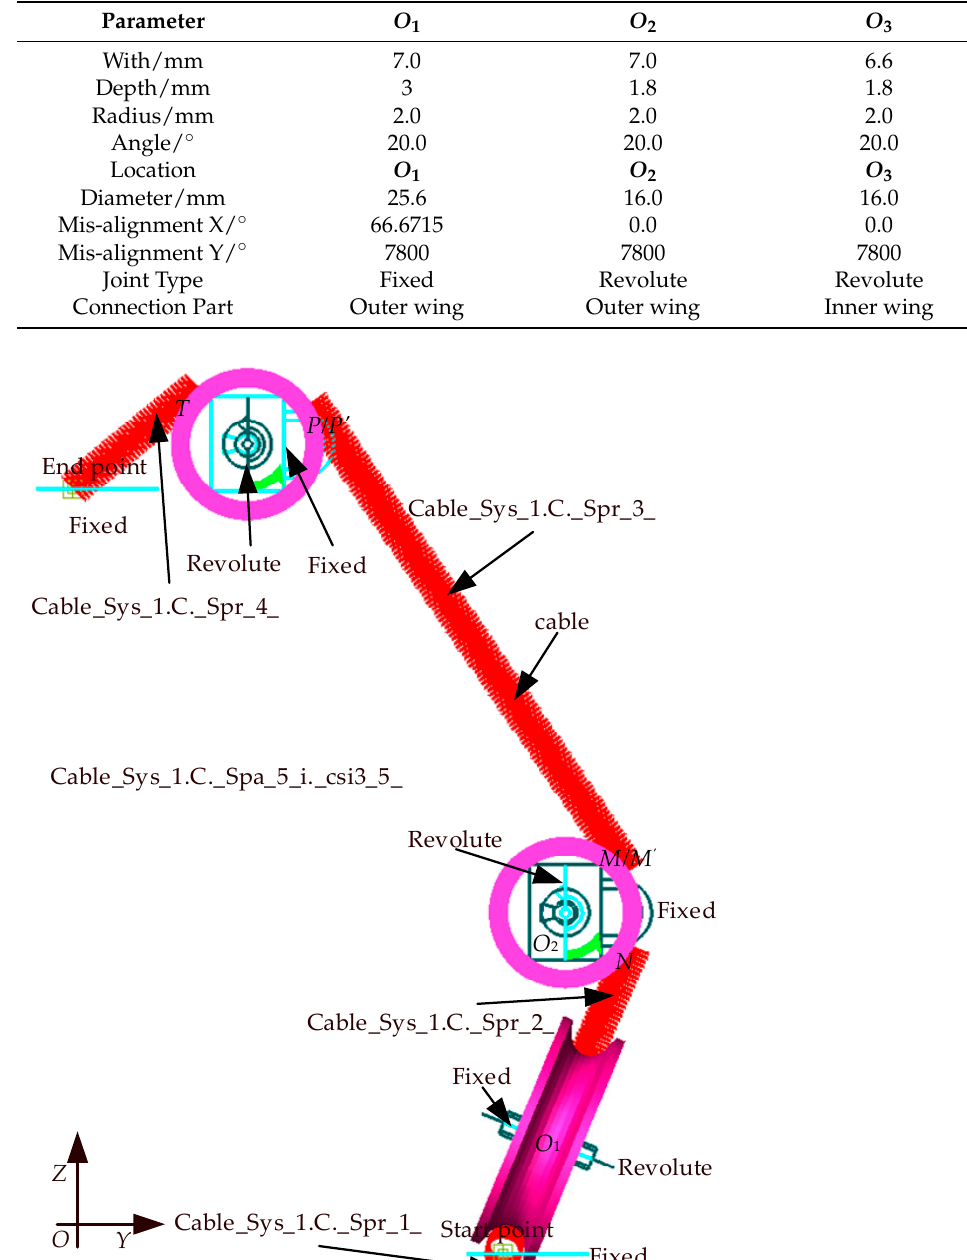
Table 1. Sectional properties of pulleys.